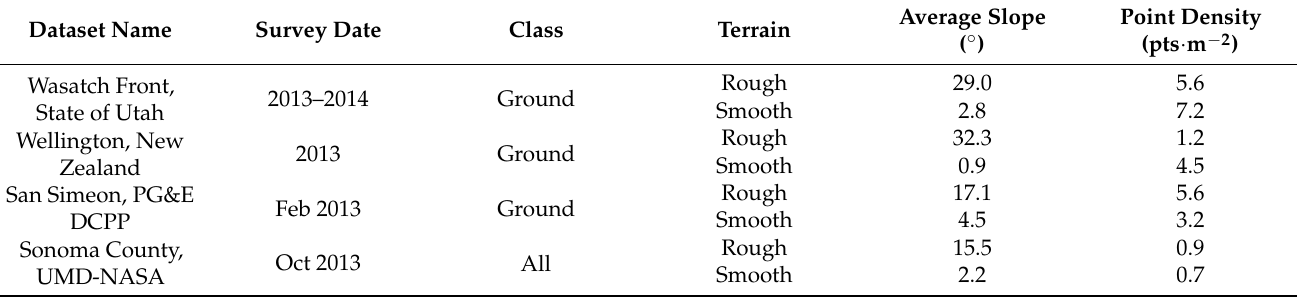
Table 1. Sample airborne LiDAR dataset